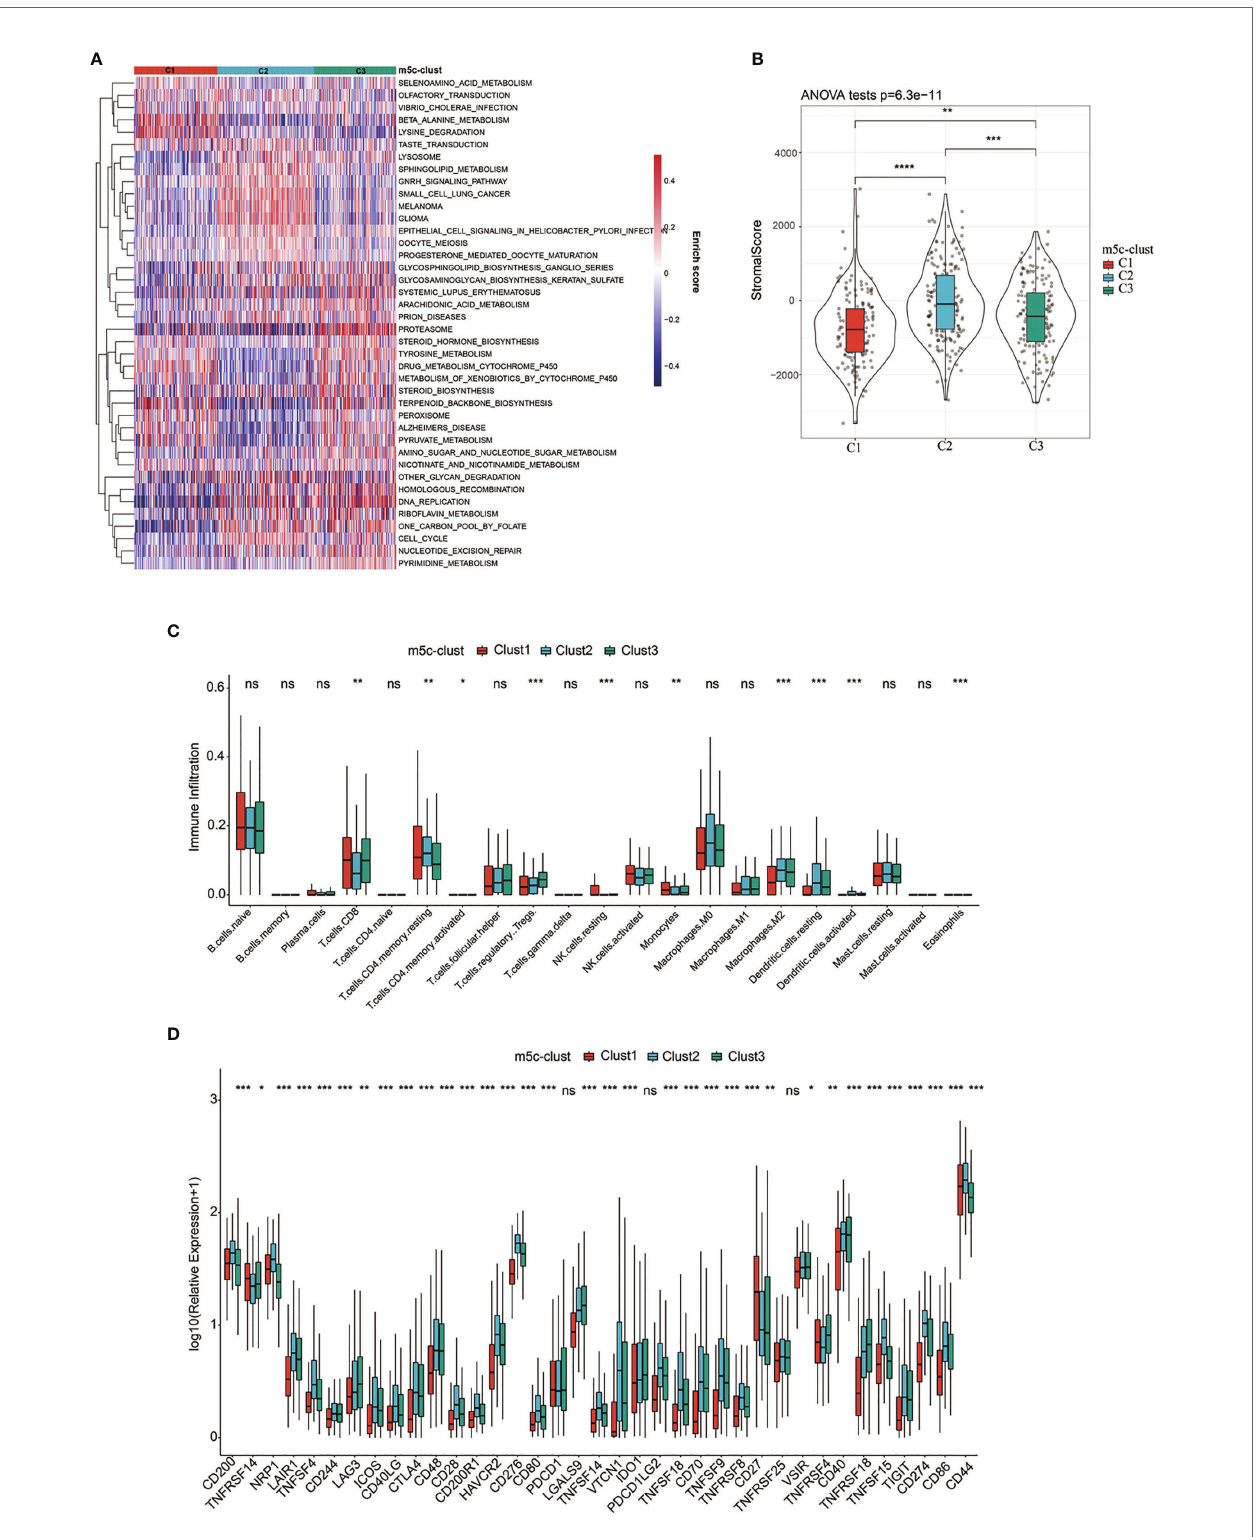
FIGURE 2 | TME-in fi ltrating cell features in different m 5 C modi fi cation patterns. (A) Biological behaviors in the different m 5 C modi fi cation patterns were conducted by GSVA. (B) Levels of stromal scores in different m 5 C modi fi cation patterns. (C) The levels of in fi ltration of 22 immune cells in different m 5 C modi fi cation patterns. (D) The expression levels of 37 immune checkpoints in different m 5 C modi fi cation patterns. *, **, ***, **** statistic difference at different levels; ns, no signi fi